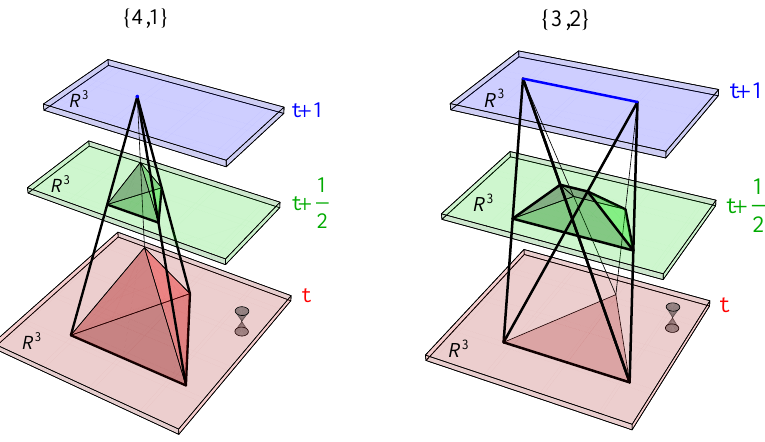
Figure 1. Visualization of the elementary building blocks of four-dimensional Causal Dynamical Triangulations (CDT), the ( 4,1 ) -simplex ( left ) and the ( 3,2 ) -simplex ( right